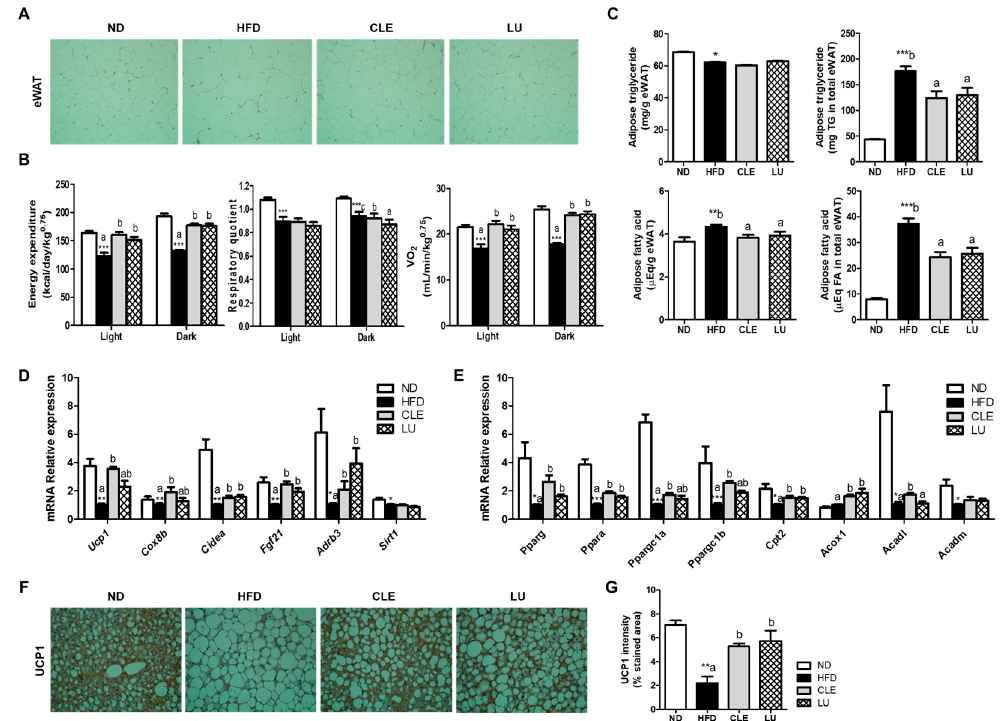
Figure 2. Effect of chrysanthemum leaf ethanol extract and luteolin supplements for 16 weeks on anti-adiposity. ( A ) eWAT morphology (magnification × 200); ( B ) energy expenditure, respiratory quotient and oxygen consumption (VO 2 ); ( C ) lipid profile of eWAT; ( D ) adipocyte gene expression of thermogenic genes; ( E ) adipocyte gene expression of lipid metabolism-related genes; ( F ) immunohistochemistry of UCP1 staining in BAT (magnification × 200); ( G ) intensity of UCP1 in BAT. Mean ± SE. Significant differences between HFD compared to ND are indicated * p < 0.05, ** p < 0.01, *** p < 0.001 (Student’s t -test). ab Means not sharing a common letter are significantly different among the HFD-fed groups at p < 0.05. Hematoxylin and eosin- and UCP1 immunohistochemistry-stained transverse-section of epididymal fat. ND, normal diet (AIN-76); HFD, high-fat diet (45% kcal from fat); CLE, HFD + chrysanthemum leaf ethanol extract (1.5%, w / w ); LU, HFD + luteolin (0.003% w / w ). eWAT, epididymal white adipose tissue; UCP1, uncoupling protein-1; BAT, brown adipose tissue.